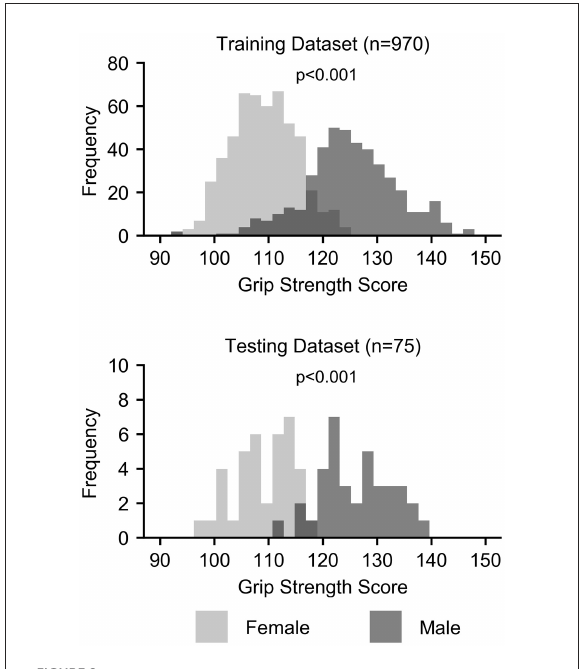
FIGURE2 Histograms of grip strength scores by sex for the training and testing